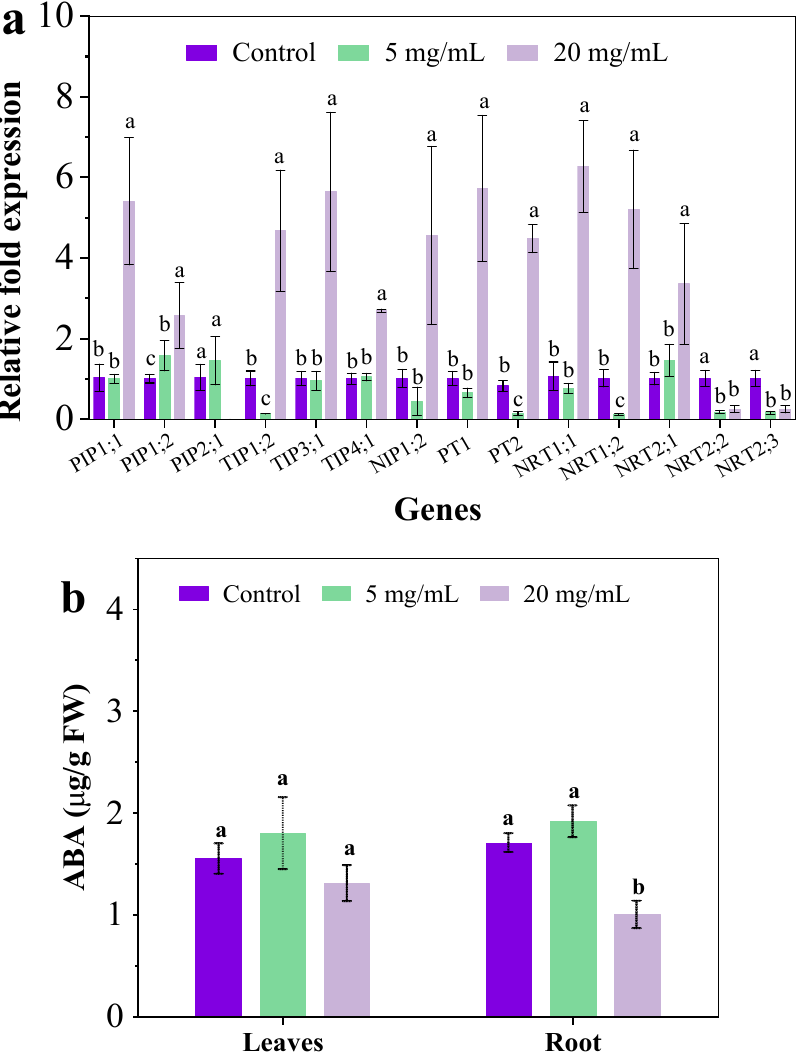
Figure 3. The relative gene expression in roots ( a ) and the ABA content ( b ) after exposure to C. camphora extract for 14 days. (The significant difference among different treatments is marked with different letters, p < 0.05.)